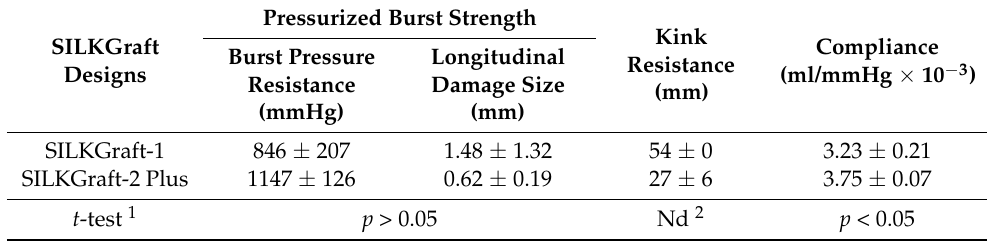
Table 5. Mechanical properties: pressurized burst strength, kink resistance, and compliance.